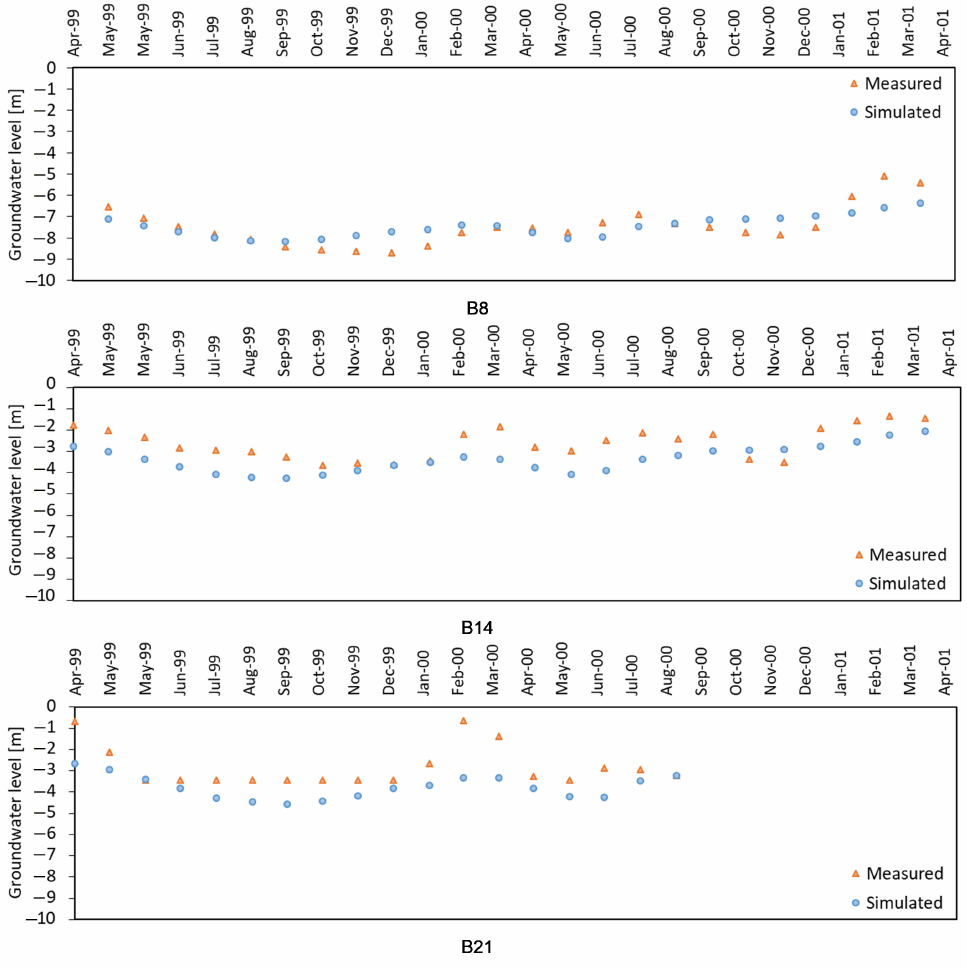
Figure 9. Time series of measured and simulated mean monthly groundwater level for the three boreholes used for model calibration and